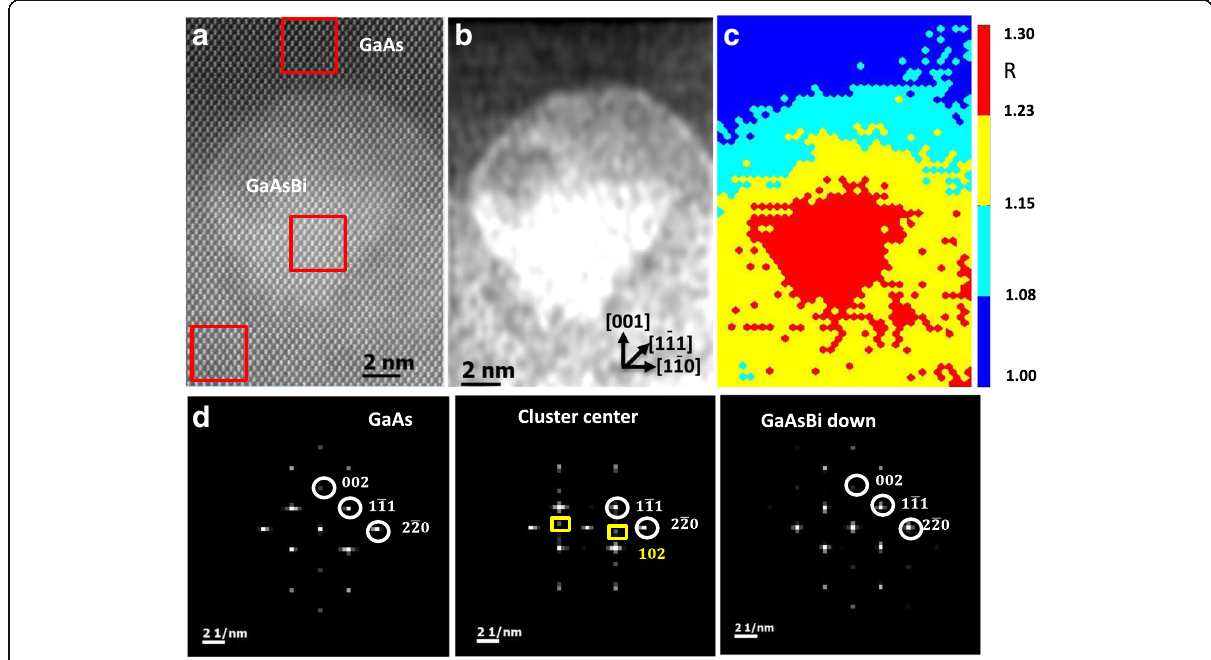
Fig. 4 a Cross-sectional [110] HAADF-STEM image of the interface GaAsBi/GaAs of sample S2, capturing a Bi cluster of about 12 nm in size, next to the GaAsBi/GaAs interface. b Low-filtered image of the HAADF-STEM image shows two areas with different contrast in the GaAsBi layer, a Bi-r- ich zone is faceted along {111} and (001) planes, surrounded by a lower Bi-rich one. c Coloured map representing the R values around group V columns depicting a graded Bi distribution around the cluster. d The corresponding Fourier transformation from the selected areas marked with red rectangles in Fig. 1a. Additional spots matching {102} planes related to rh-Bi phase are detected in the highest contrast cluster